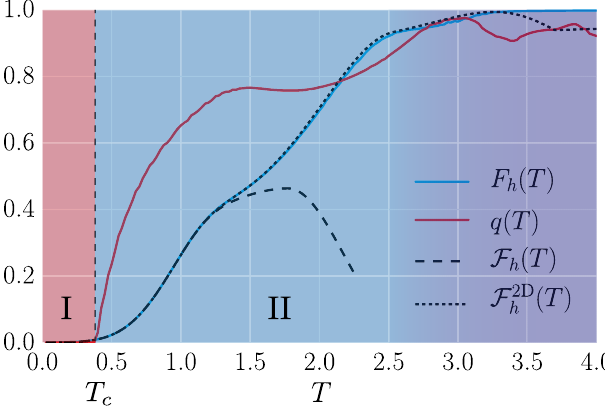
FIG. 3. Phase diagram of the many-body quantum-state manipulation problem. The order parameter (red) shows a kink ≈ 0 . 4 when a phase transition occurs from at the critical time T c an overconstrained phase (I) to a glassy phase (II). The best T Þ (blue) obtained using SD is compared to the fidelity F h ð T Þ (dashed) and the 2D-variational fidelity variational fidelity F h ð F 2 D ð T Þ (dotted) h